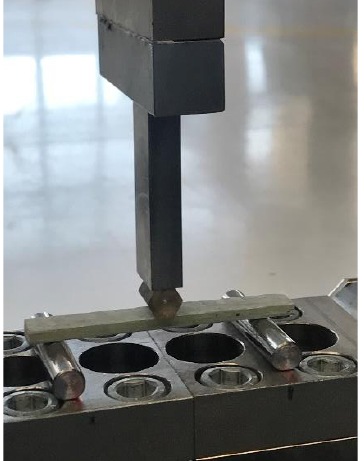
Figure 2. The specimen during bending flexural test. Table 2. Results of flexural tests (mean values and standard